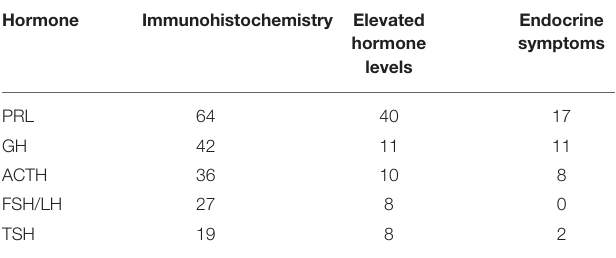
TABLE 3 | Relationship among immunohistochemistry, clinical hormone levels, and endocrine symptoms.